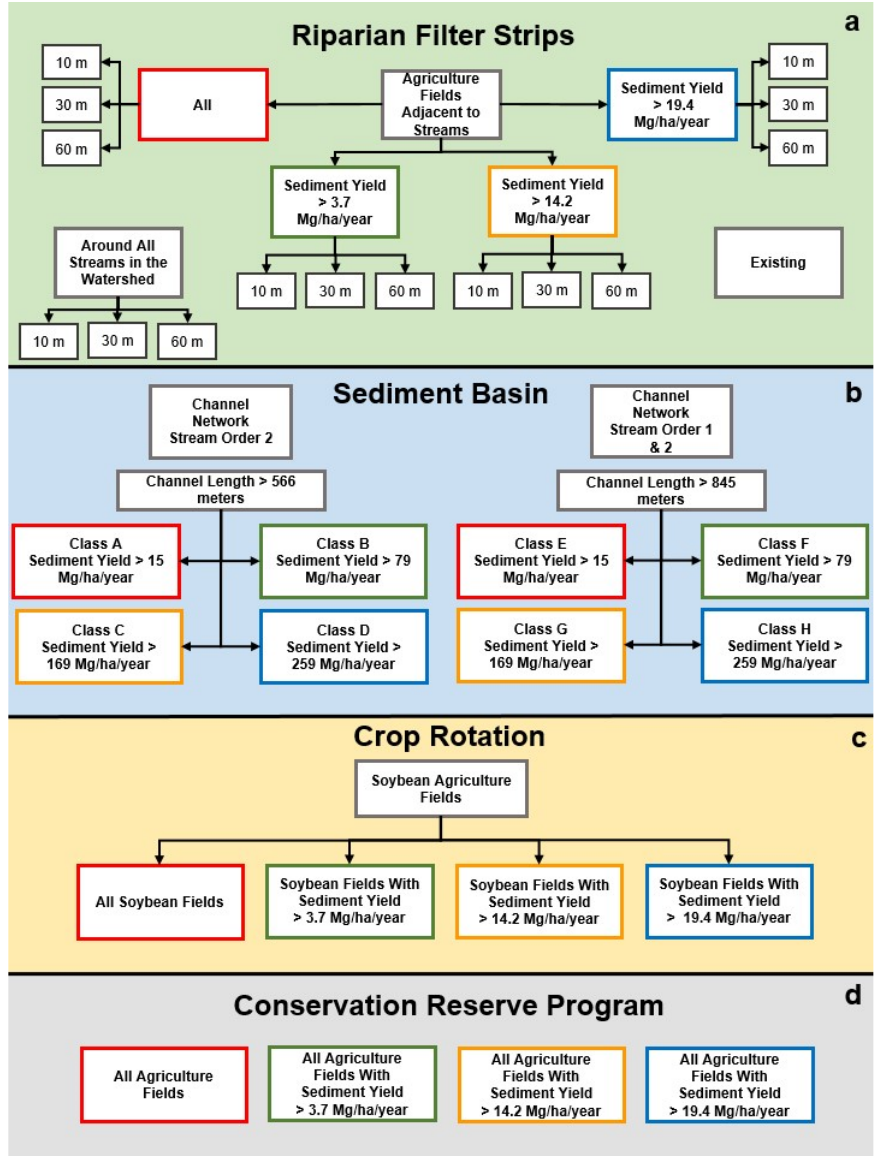
Figure 6. Flowchart summarizing all simulated conservation practice scenarios and their differences ( a – d ).